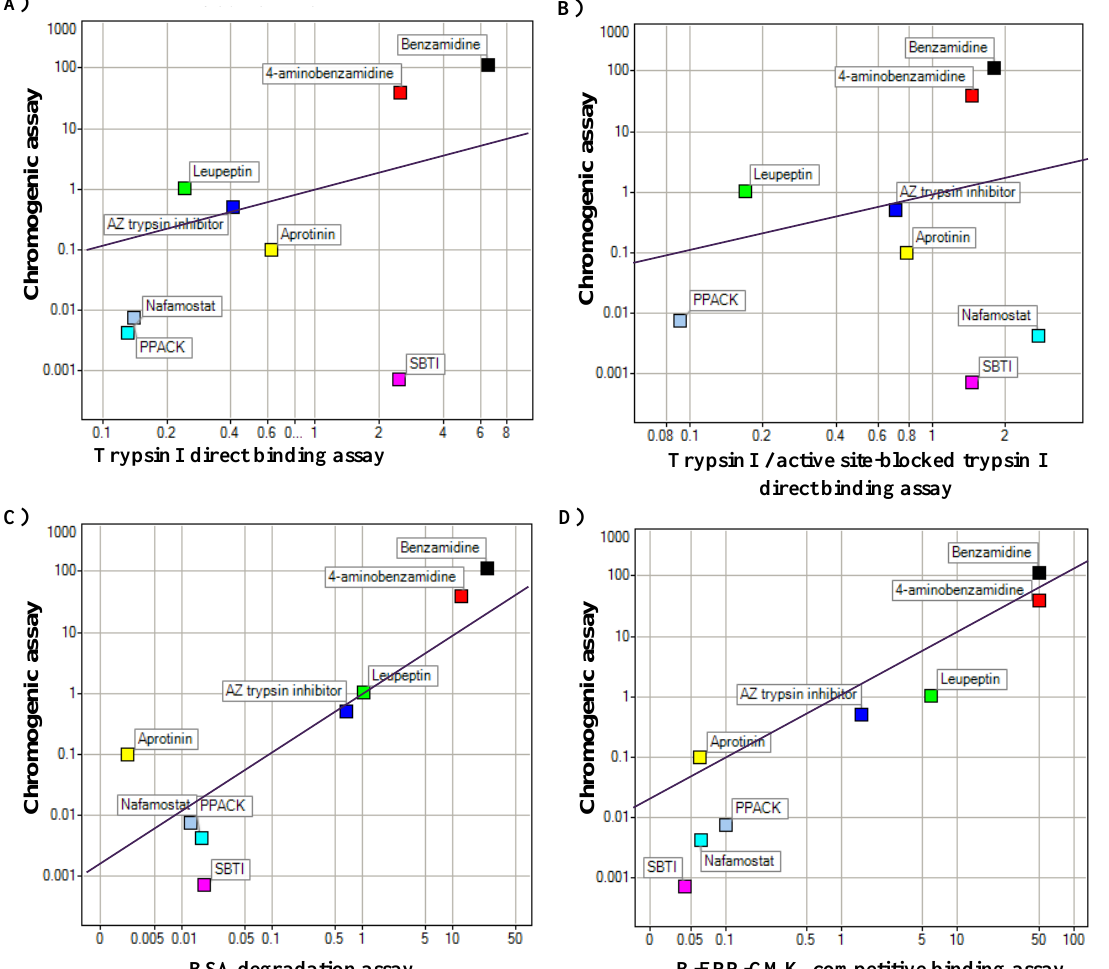
Figure 2. Comparison of the chromogenic assay with the optical biosensor based assay formats for a selection of small molecule and protein inhibitors. IC chromogenic assay are in µM, for the DBA in ( A ) and ( B ) K the substrate degradation assay ( C ) and the ISA ( D ), IC lines show a 1:1